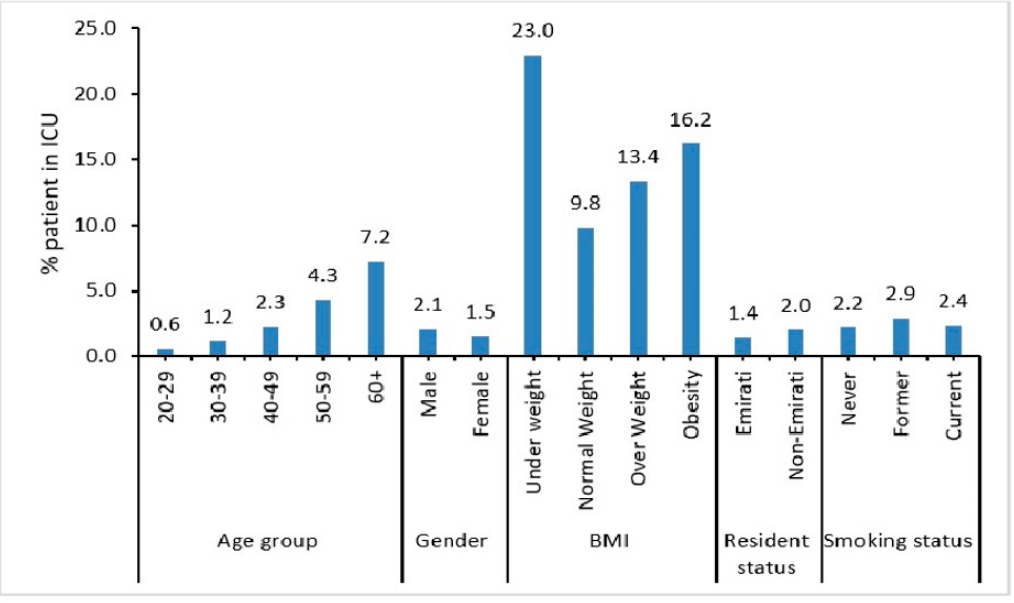
A higher percentage of elderly, i.e., aged 60 years and above (7.2%) and male patients (2.1%) were admitted into the ICU (Figure 2). Also, patients who did not maintain normal weight (i.e., underweight (23%), obese (13.4%), or overweight (16.2%)) were more likely to be admitted into the ICU.